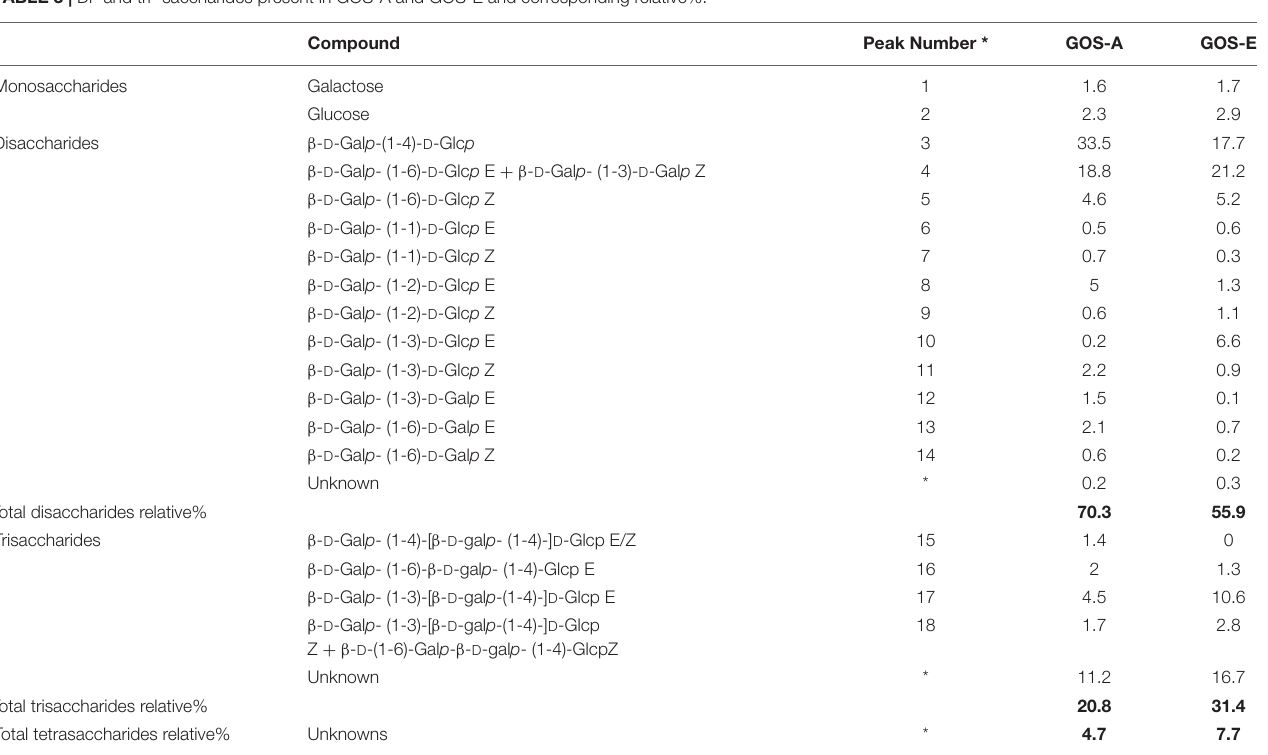
*See Figure. Total disaccharide relative % for GOS-A and GOS-E are highlighted in bold.